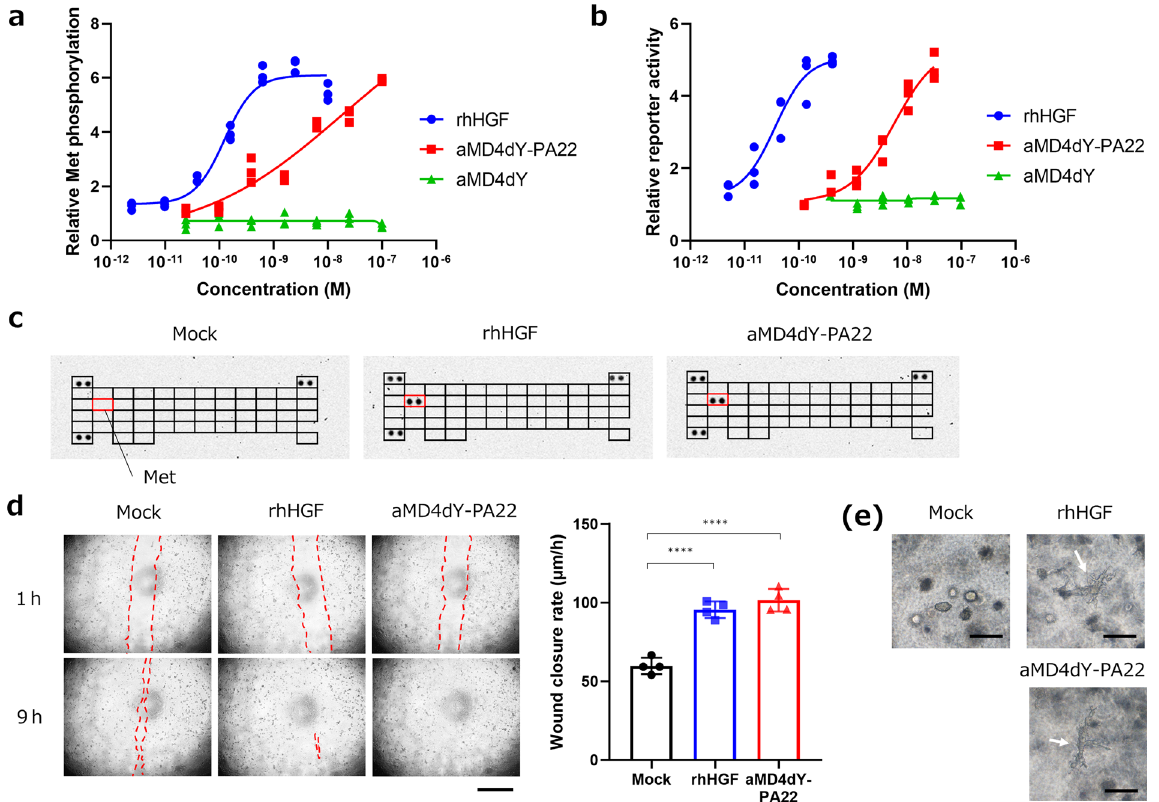
Fig. 3 Bioactivity evaluation of aMD4dY-PA22. a Phosphorylation of Met induced by aMD4dY-PA22. Met phosphorylation (Y1234/Y1235) level of HuCCT1 cells stimulated using aMD4dY-PA22 (red squares), rhHGF (blue circles), and monomeric aMD4dY (green triangles) was evaluated via phosphor-Met ELISA. The mean and individual values are shown from the results of triplicate experiments. b Signaling potencies induced by aMD4dY- PA22. Erk signaling activation by aMD4dY-PA22 (red squares), rhHGF (blue circles), and monomeric aMD4dY (green triangles) was evaluated by Erk-SRE reporter assay. The mean and individual values are shown from the results of triplicate experiments. c Selectivity of aMD4dY-PA22 against various RTKs. Cell lysates of HEK293 cells stimulated by 1.3 nM rhHGF or 32 nM aMD4dY for 10 min were analyzed by a phospho-RTK array. Positions of phospho-Met are indicated by red boxes. d Wound healing promoted by aMD4dY-PA22. Wound closure events of HuCCT-1 cell monolayer at 1 and 9 h after scratching with or without 0.41 nM rhHGF or 16 nM aMD4dY-PA22 were captured. Scratches are depicted by red broken lines. Scale bars = 1 mm. Average wound closure rates from 1 to 7 h of each experimental group were calculated. The mean ± SD with individual values are shown from the results of quadruplicate experiments. **** p < 0.0001. e Branching morphogenesis induced by aMD4dY-PA22. HuCCT-1 cells were encapsulated in collagen gels and cultured in